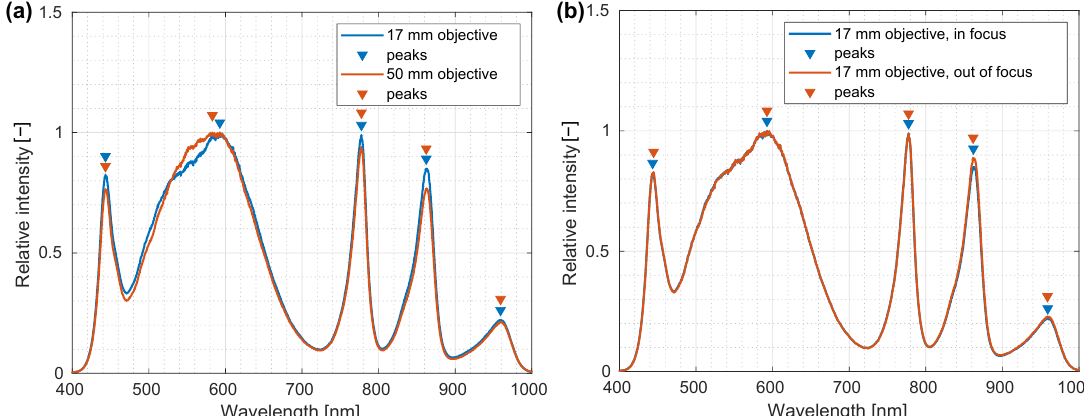
Figure 8. Verification of in-focus and out-of-focus spectral calibration of a custom-made laboratory hyperspectral imaging (HSI) system. ( a ) LED illumination spectra for 50 mm (red line) and 17 mm (blue line) objective lenses. Some differences in spectral shape that are due to different objective lens coatings are also visible in the recorded spectra. Most importantly, a 17 mm objective lens had a slightly decreased transmittance between the 550 nm and 600 nm when compared to a 50 mm objective lens. ( b ) Spectra recorded at a focus plane and 10 cm above the sample recorded using a 17 mm objective lens. Detected peak intensity wavelengths are annotated on the plots and are mostly independent of the distance between the light source and